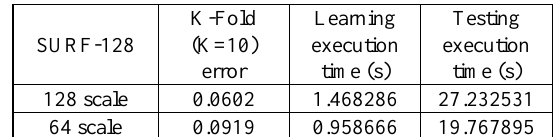
Table 1. SURF error and execution